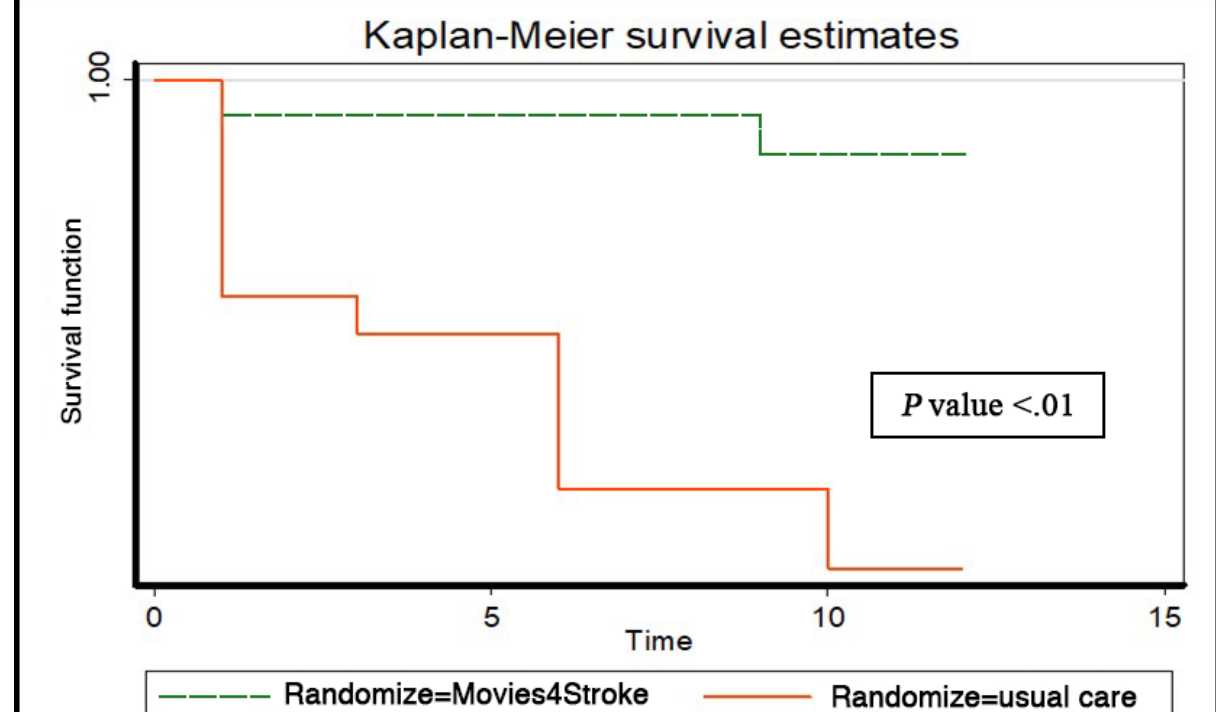
Figure 4. The Kaplan-Meier survival estimates in the first year after stroke in the intervention versus control group because of stroke-related avoidable